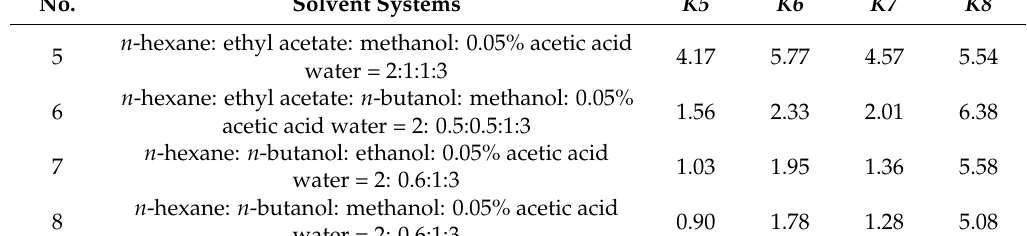
Table 3. K -values of the compounds in different two-phase solvent systems of the second step of high-speed counter-current chromatography separation.